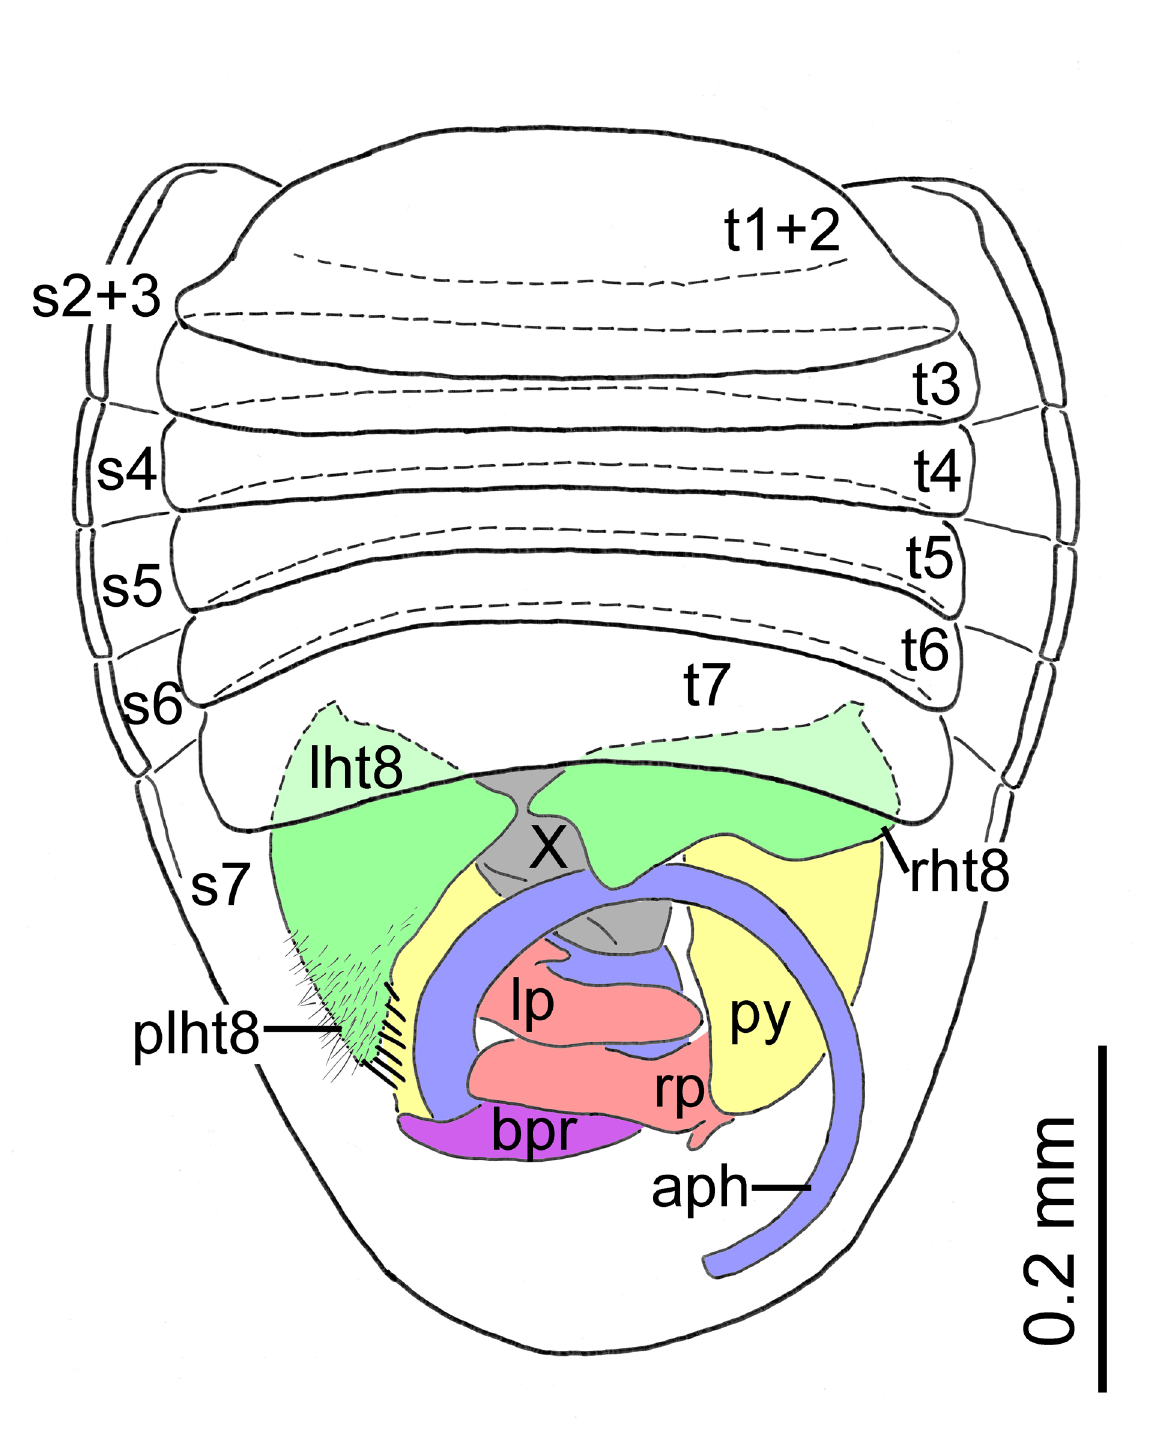
Fig. 31. Pregenital abdomen and genitalia of Kokeshia zhengi Rédei, Ren & Bu, 2012, holotype, ♂ (NKUM), dorsal view. Abbreviations: see Material and